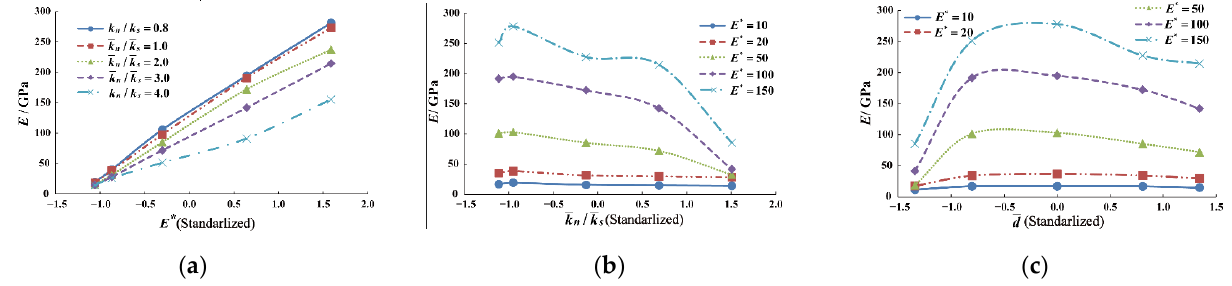
Figure 11. Joint effect of multiple meso parameters on elastic modulus: ( a ) Equivalent modulus and parallel bond stiffness ratio; ( b ) Parallel bond stiffness ratio and equivalent modulus; ( c ) Control gap of parallel bond and equivalent modulus.